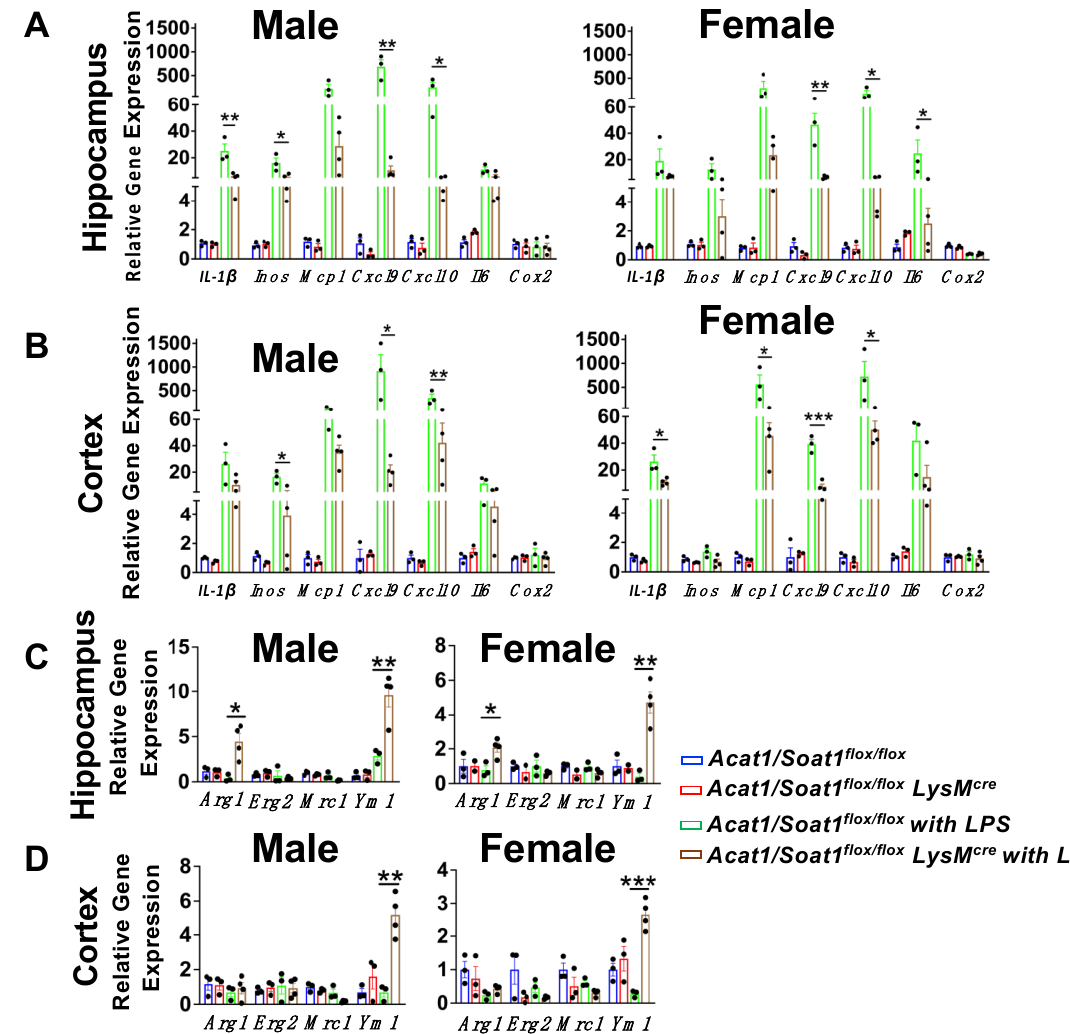
Figure 1. Myeloid Acat1 / Soat1 blockade alters the inflammatory gene profile in mouse ( A , C ) hippocampus and ( B , D ) cortex after LPS injection. Two-month-old Acat1 / Soat1 flox / flox and Acat1 / Soat1 flox / flox LyzMCre (myeloid Acat1 / Soat1 knockout) mice as littermates were injected peritoneally with LPS at 5 mg/kg body weight. After 24 h, mice were sacrificed, and mRNA was extracted from hippocampus and cortex. qPCR was performed for pro-inflammatory ( A , B ) or anti-inflammatory ( C , D ) gene expression. Left panels: male mice. Right panels: female mice. n = 4 mice. * p < 0.05; ** p < 0.01; *** p < 0.001.